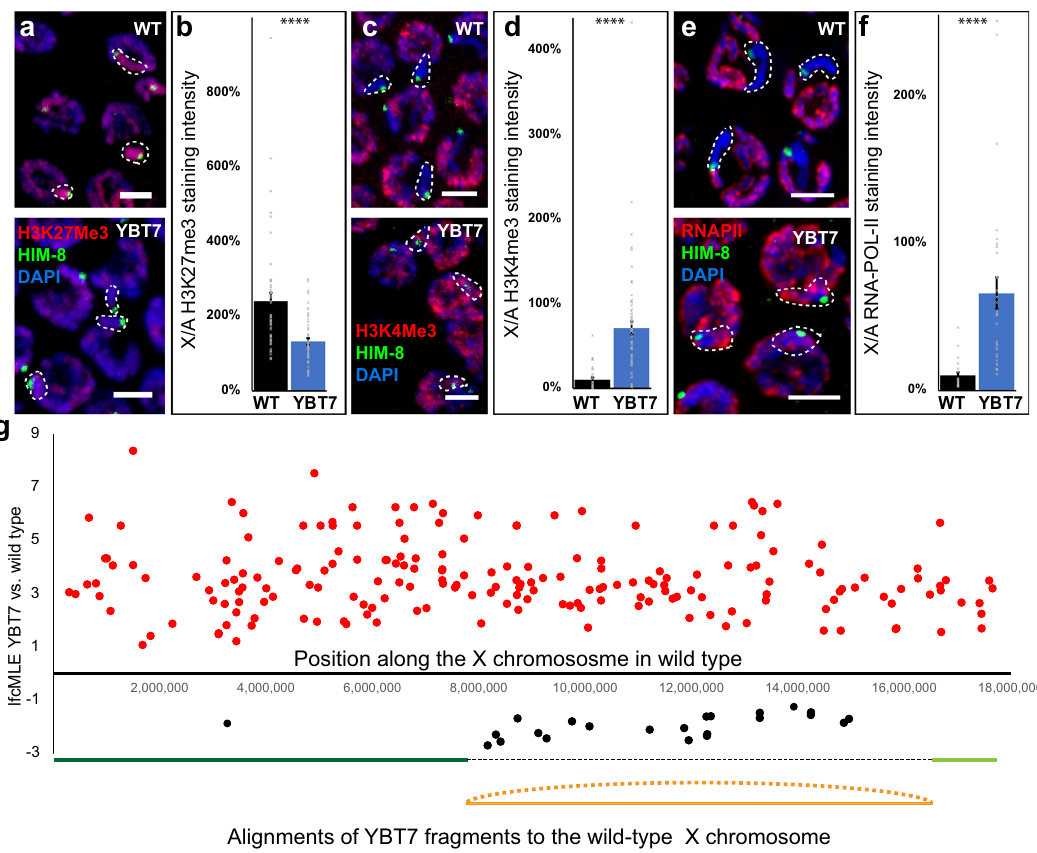
Fig. 2 Transcription of X segments is higher in meiocytes of YBT7 than wild type. a Mid-pachytene nuclei stained with DAPI (blue), anti-HIM-8 (green), and antibody against H3K27me3 (red). b Averages ± SEM of the relative H3K27me3 signals in wild-type and YBT7 nuclei on HIM-8-marked body vs. an autosome. n = 47 and 55 nuclei for WT and YBT7, respectively. c Mid-pachytene nuclei stained with DAPI (blue), anti-HIM-8 (green), and antibody against H3K4me3 (red). d Averages ± SEM of the relative H3K4me3 signals in wild-type and YBT7 nuclei on HIM-8-marked body vs. an autosome. n = 33 and 66 nuclei for WT and YBT7, respectively. e Mid-pachytene nuclei stained with DAPI (blue), anti-HIM-8 (green), and antibody against RNAPII (red). f Averages ± SEM of the relative RNAPII signals in wild-type and YBT7 nuclei on HIM-8-marked body vs. an autosome. n = 22 and 31 nuclei for WT and YBT7, respectively. **** p < 0.0001, by the two-tailed Mann – Whitney test. Scale bar = 3 μ M. g RNA-seq results. Plotted is log 2 of the fold-change maximum likelihood estimate (lfcMLE) of YBT7 vs. wild type for each gene along the X chromosome. Only highly differentially expressed genes are illustrated. Alignments of the linear (green) and internal (orange) segments of YBT7 are shown schematically below the